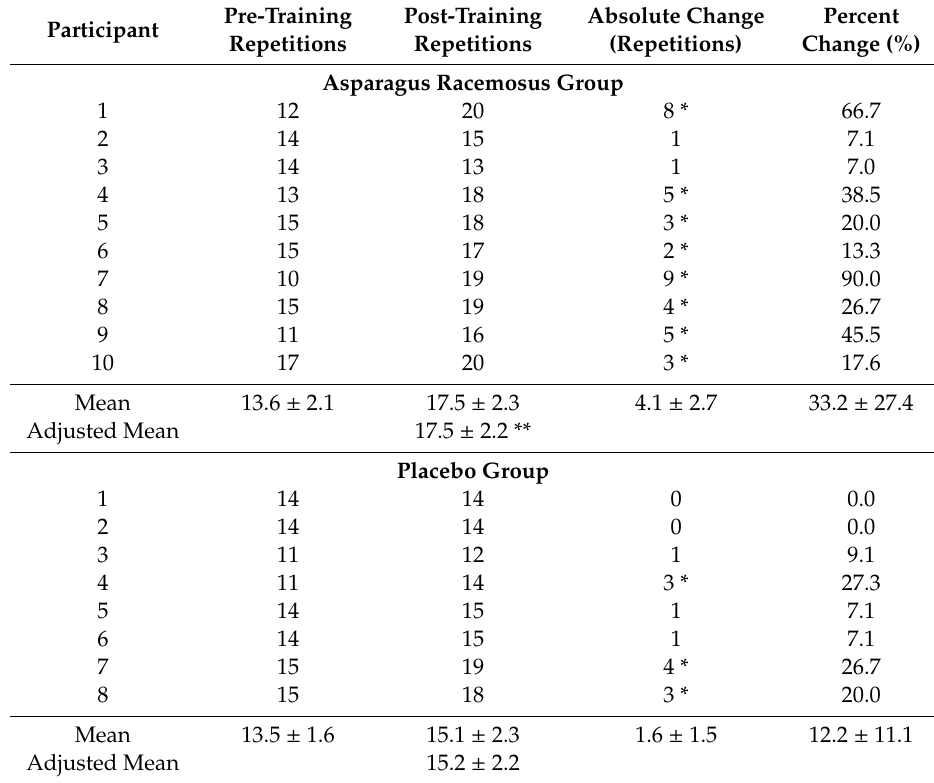
Table 5. Individual values as well as absolute and adjusted mean ± SD values for pre-training and post-training bench press repetitions to